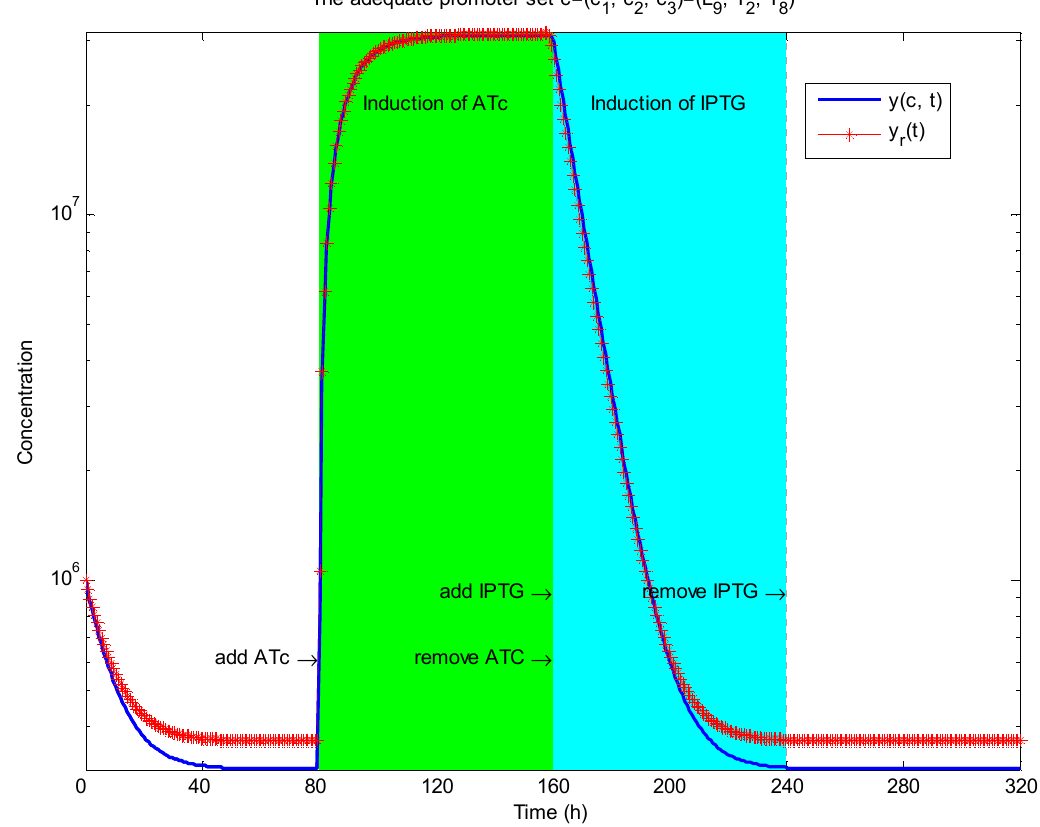
Figure 12. Simulation of toggle switch. By solving the LMI-constrained optimization problem of the H / H design objective Equations (3.23) and (3.24) for the synthetic gene 2 ∞ network in Figure 11 through the library searching method, an adequate promoter set c = [ c , c ] = [ L , T , L ] is selected from the corresponding promoter libraries. The inducer ATc c 2 3 9 2 8 is added to the synthetic gene network at 80–160 hours to induce the gene network, and then the inducer IPTG is added at 160–240 hours. The output y ( c , t ) clearly produces a robust track with the desired reference output y ( t r